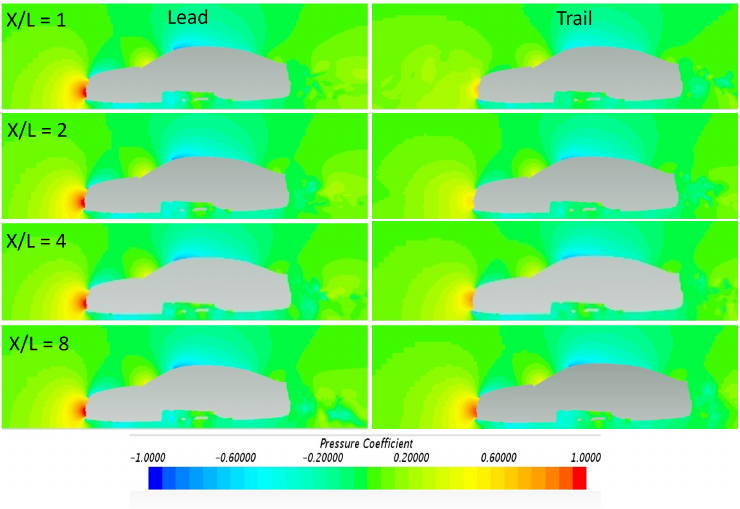
Figure 19. The pressure coefficient on the front of the trailing car at different tested separations.